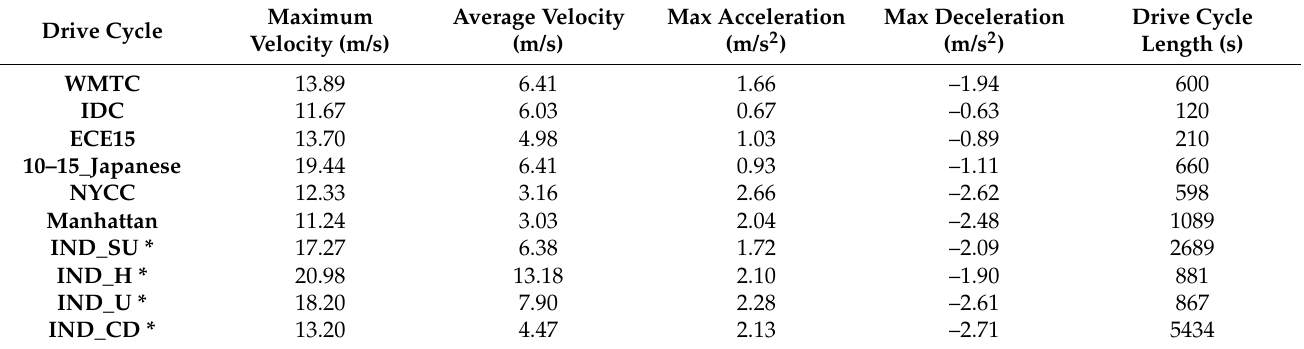
Table 1. Drive cycles considered for the study (standardised drive cycle and on-road driving data (*)). Drive